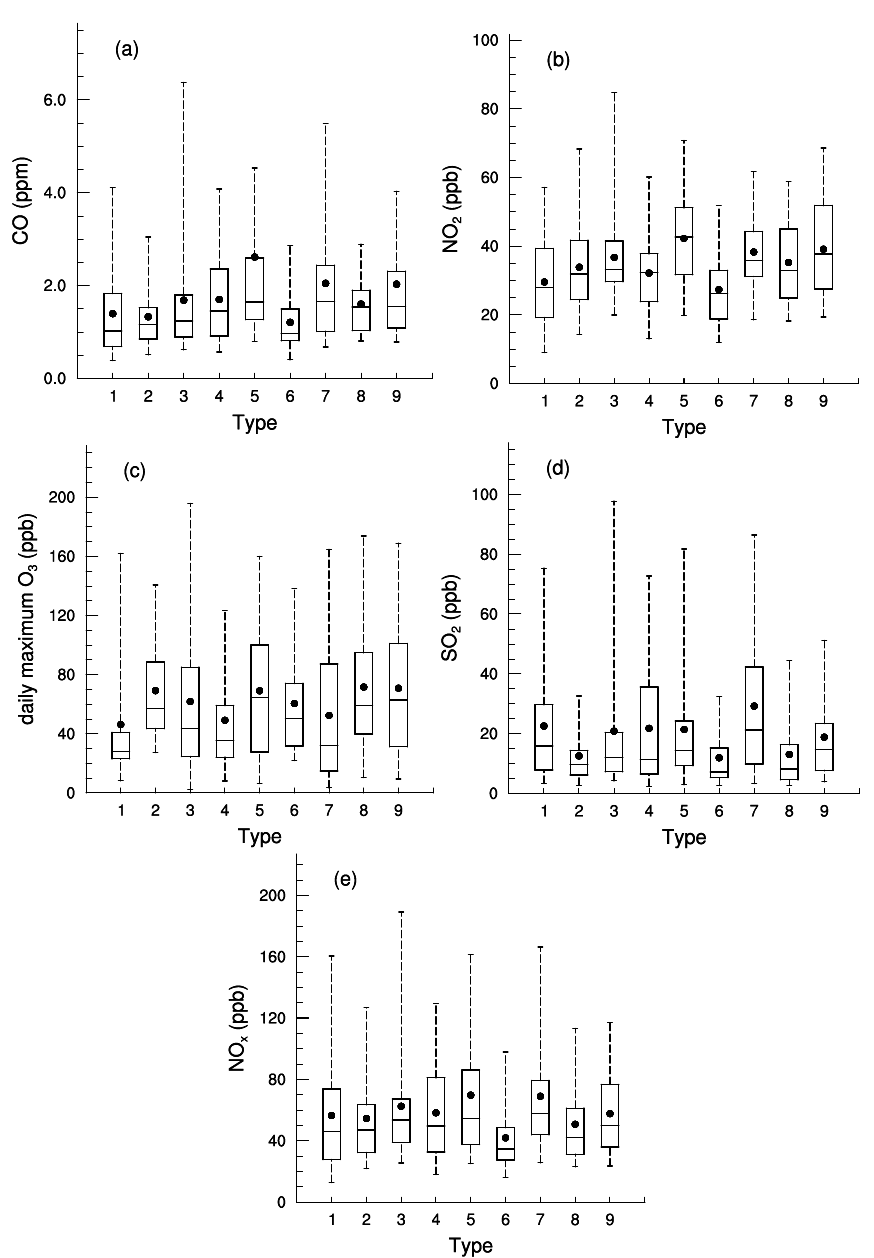
Fig. 10. As in Fig. 6 but for CO, NO 2 , daily maximum O 3 , SO 2 and NO x mixing ratio at PKU during the period August 2006 to October 2008.